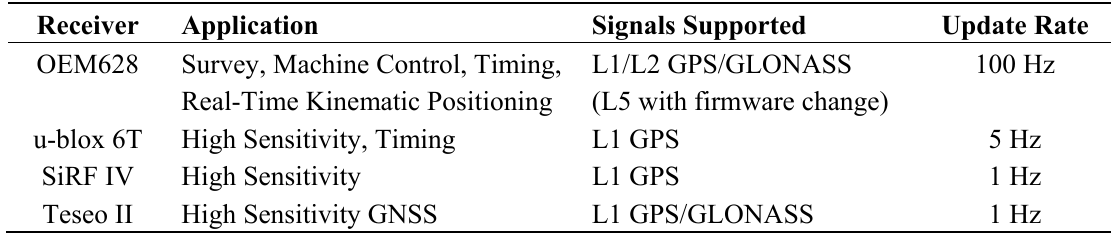
Table 1. GNSS receivers supported by the NavCube system and their typical application